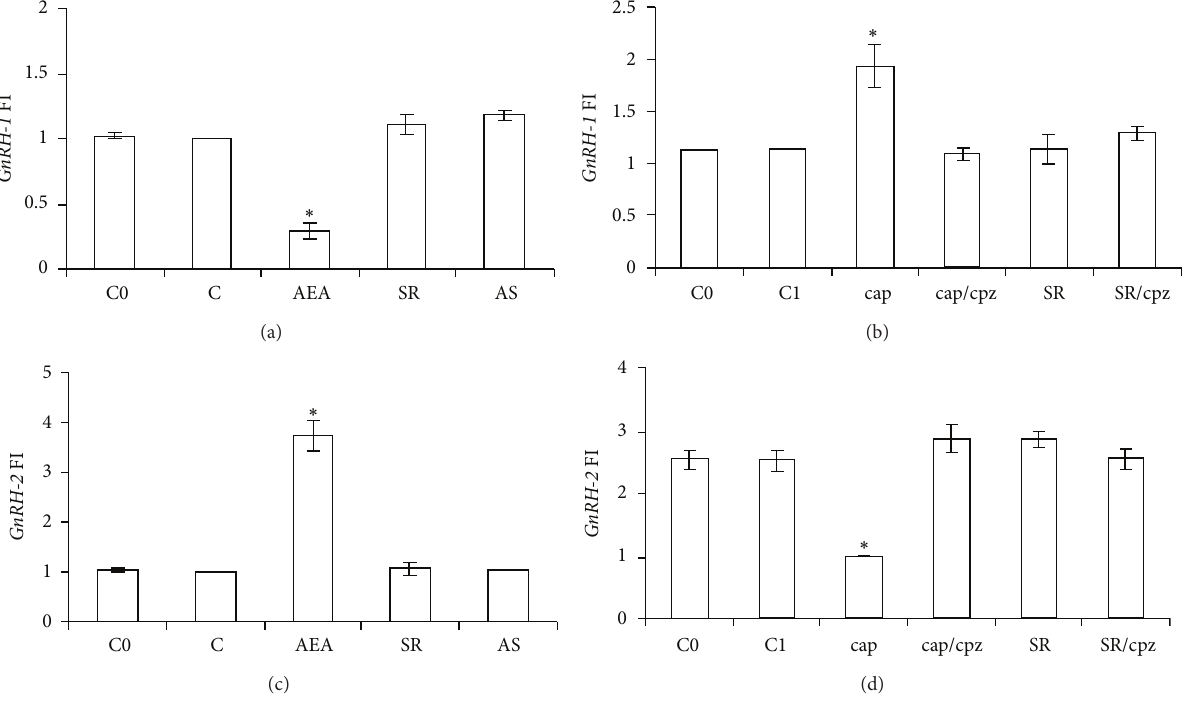
Figure 3: Effects of AEA treatment on GnRH-1 (a) and GnRH-2 (c) expression in frog testis collected from June animals ( 𝑁 = 5 /group) after 1h of incubation. Incubations have been carried out with AEA 10 −9 M, SR 10 −8 M, or both. C0: untreated testis of June; C: control group, testis treated with Krebs-Ringer buffer. Effects of cap treatment on GnRH-1 (b) and GnRH-2 (d) expressions in frog testis of June after 1h of incubation. Incubations have been carried out with cap 10 −6 M, cpz 10 −5 M, SR 10 −8 M, or combinations of cap/cpz and SR/cpz. C0: untreated testis of June; C1: control group, testis treated with Krebs-Ringer buffer. The data in graph are the results of RT-PCR analysis; they are reported as fold increase (FI) calculated comparing the expression of GnRH-1 / GnRH-2 to the housekeeping fp1 and are representative of three separate experiments at least ( 𝑁 = 6 ). Asterisks indicate statistically significant